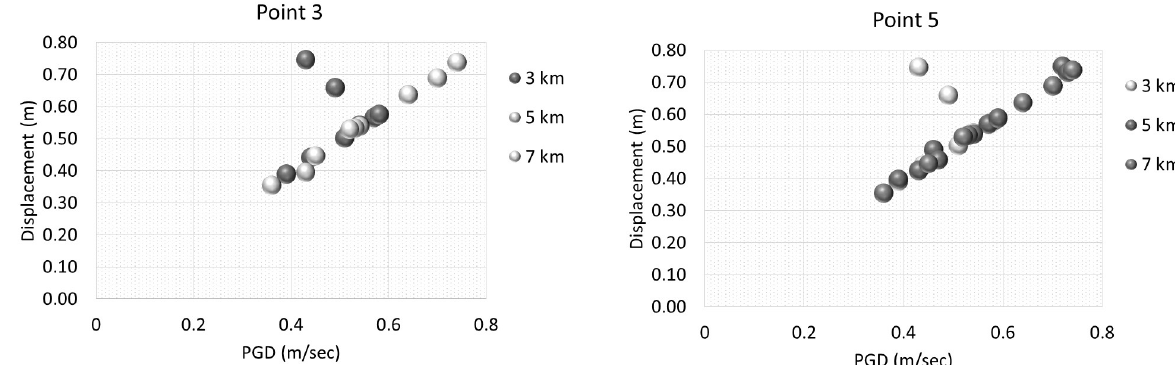
Figure 5. Variation of maximum displacements with peak ground displacement for history points 3 and